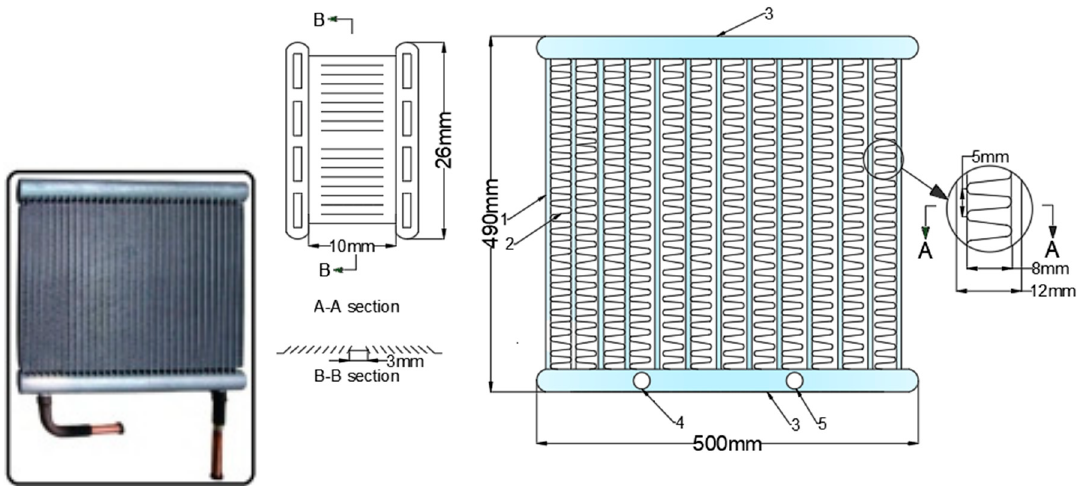
Table 1. Specifications of measurement instruments.